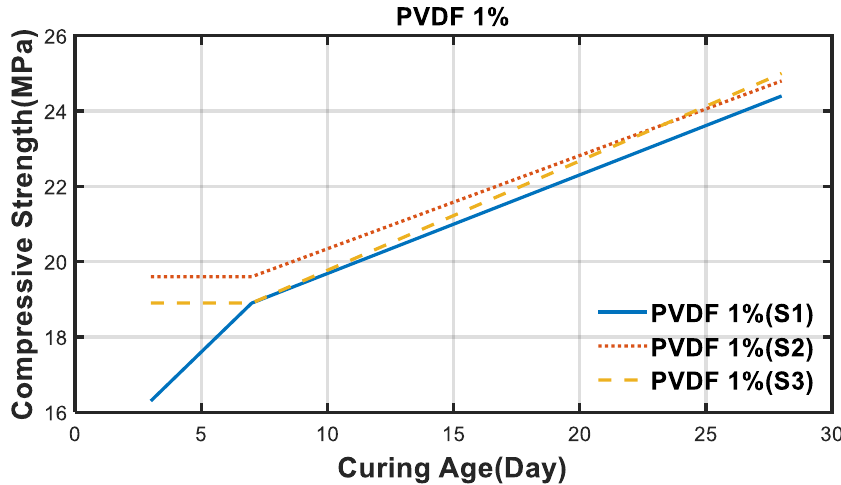
Figure 9. Graph of strength measurement results between PVDF (1%) specimens.